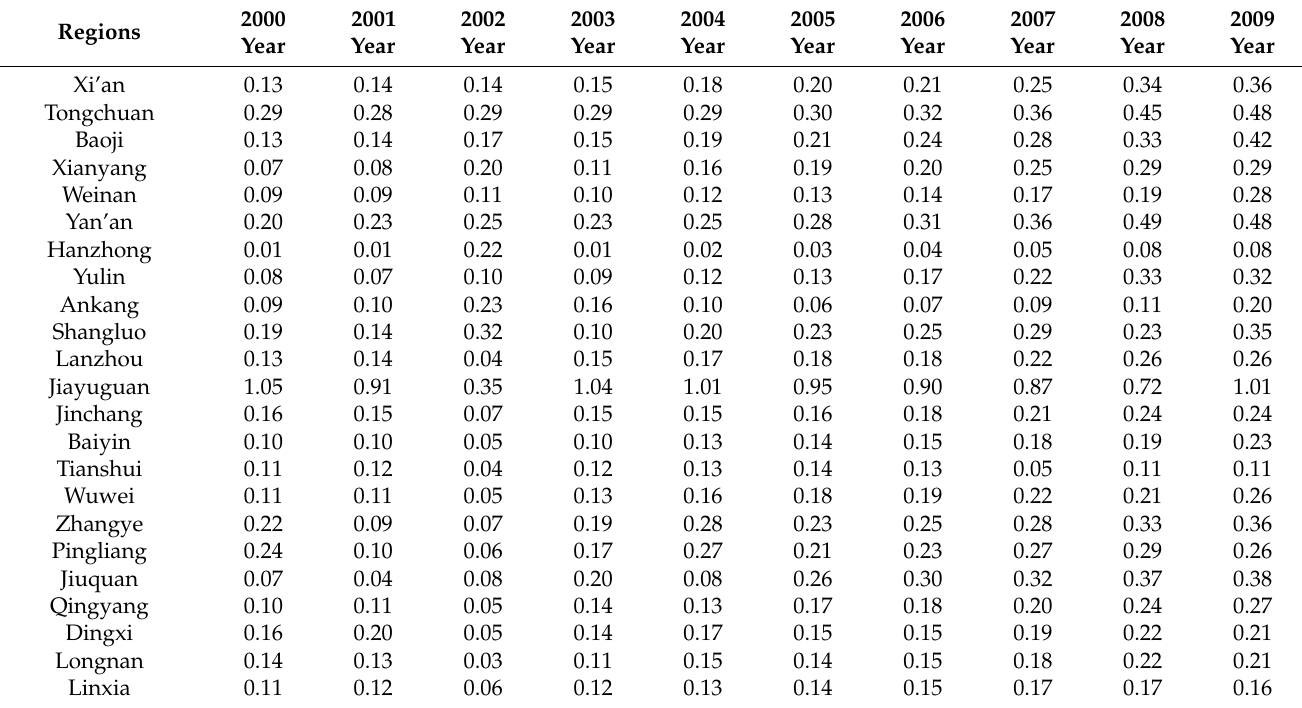
Table A1. The AWUE in China from 2000 to